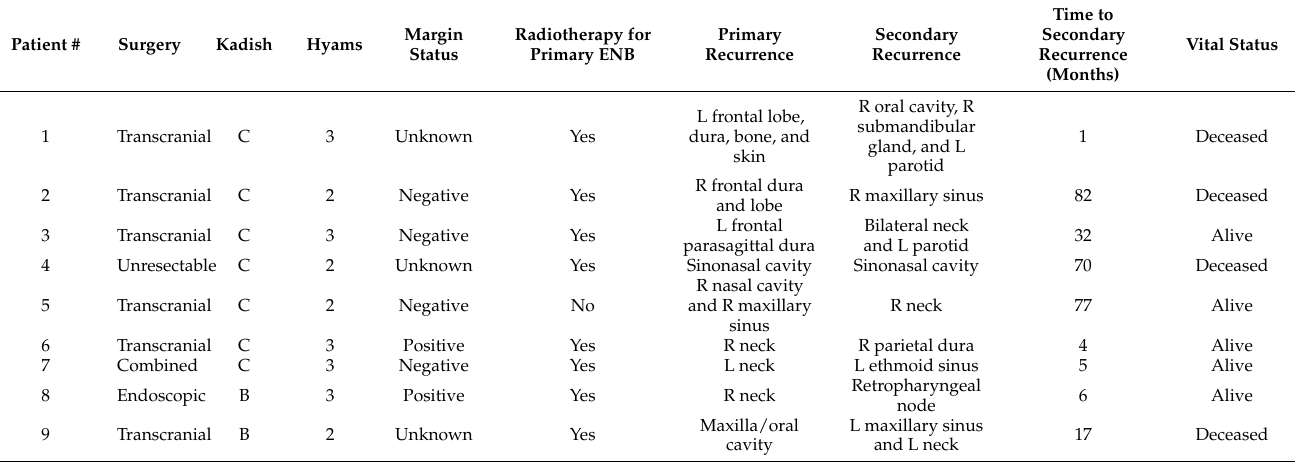
Table 6. Esthesioneuroblastoma secondary